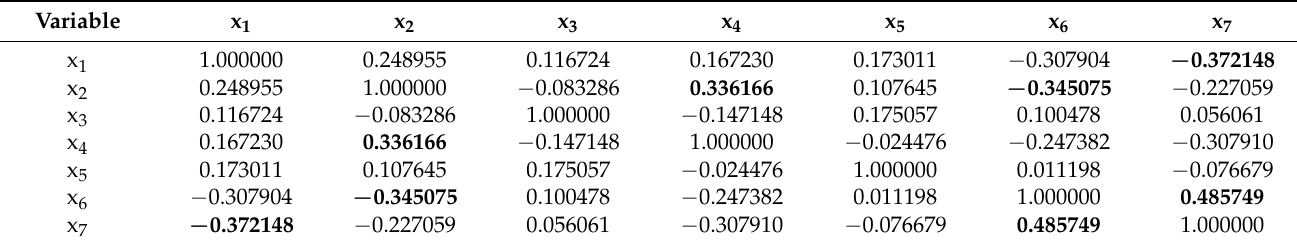
Table 3. Spearman rank-order correlations MD pairwise deleted marked correlations are significant at p <